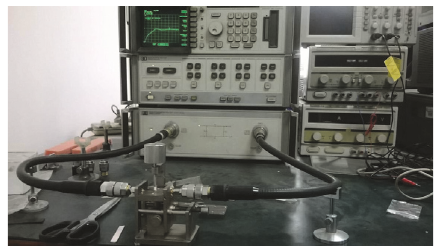
Figure 8: The photograph of the designed measurement equipment.